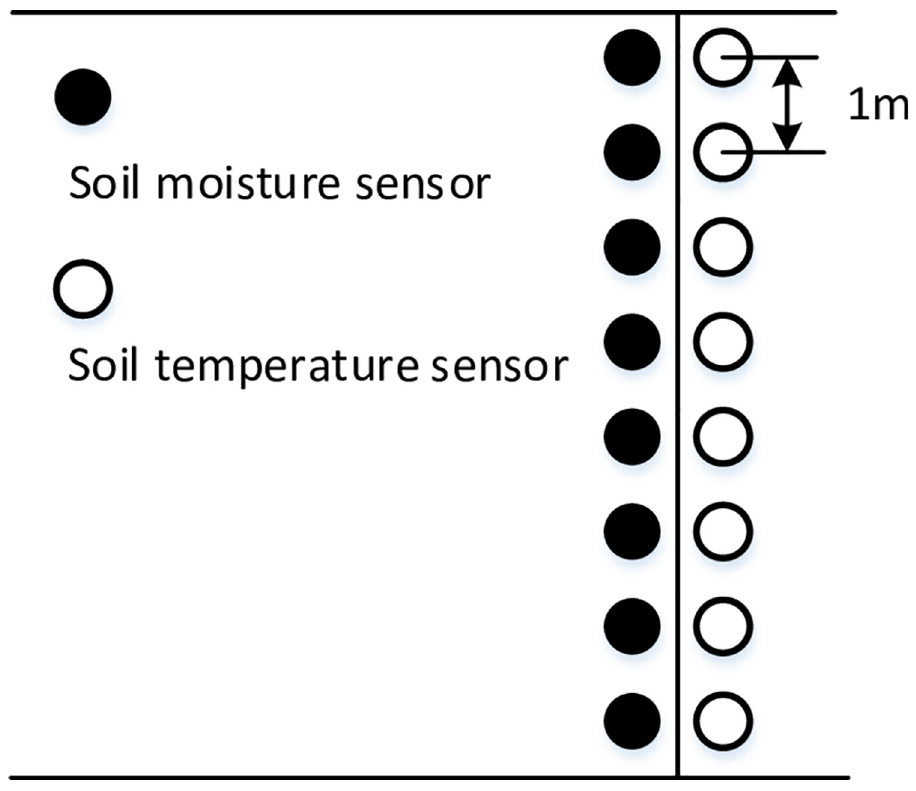
Fig 12. Sensors buried